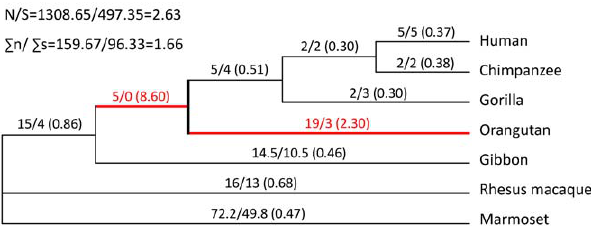
Figure 1. Phylogeny and positive selection of primate SAMHD1 genes. The actual numbers of n/s changes and v values (dN/dS, in parentheses) are shown above each branch. N and S are the potential numbers of non-synonymous and synonymous sites, respectively. The thick red lines represent the branches under positive selection.